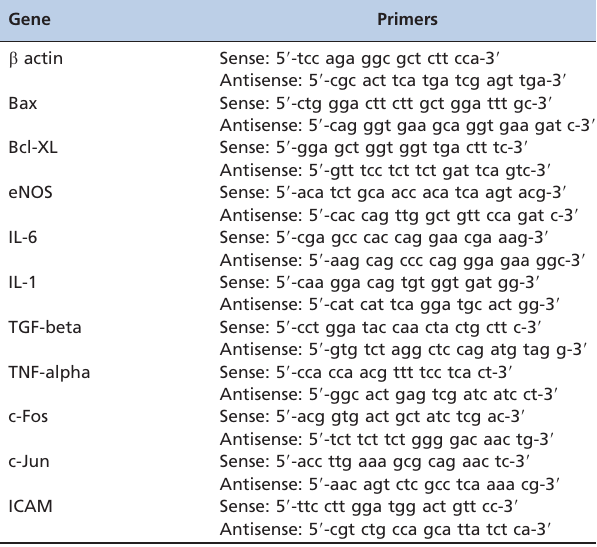
Table 1 - Primer sequences. Gene Primers